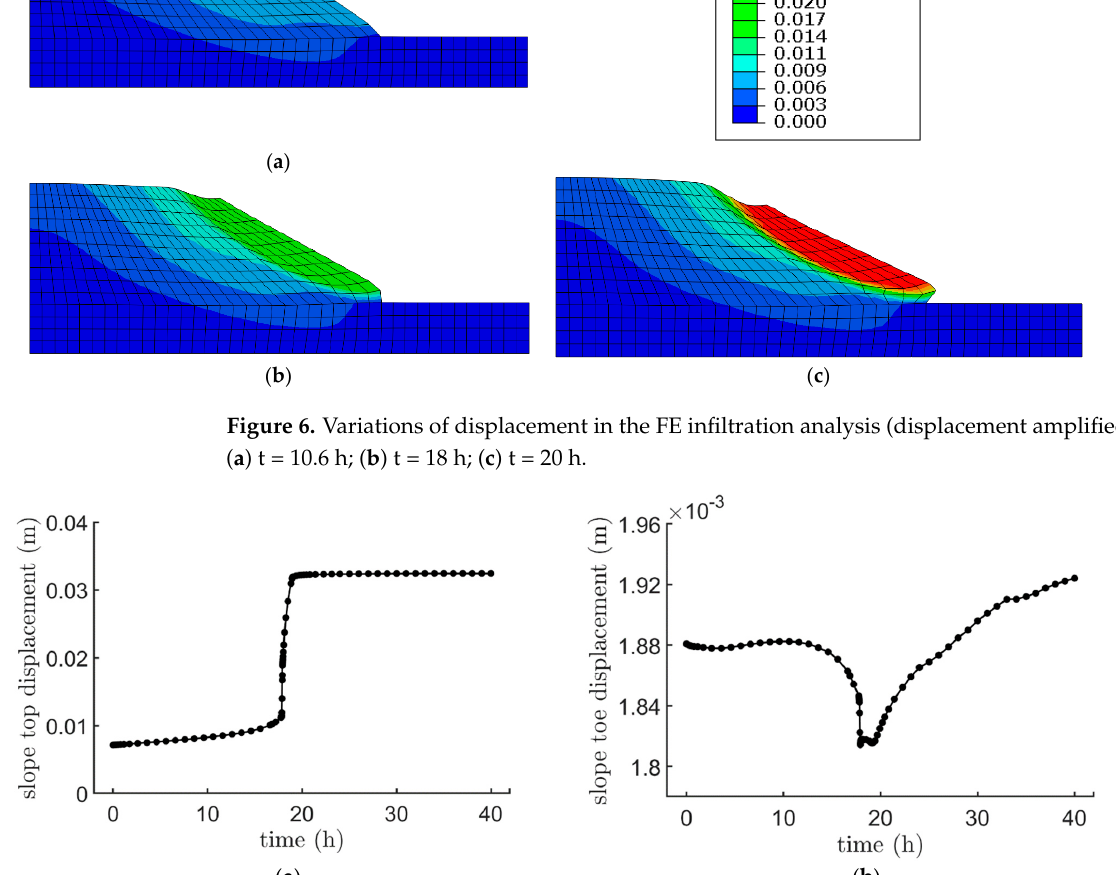
Figure 7. Variations of displacement in tow positions: ( a ) slope top; ( b ) slope toe.